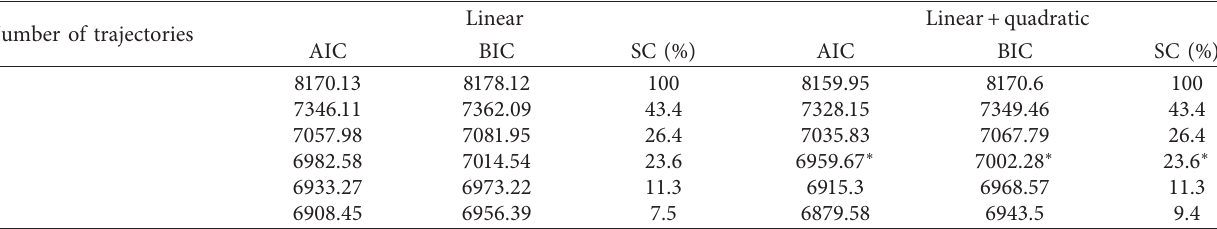
Figure 2: Acute postoperative median pain intensity of patients ( n � 106). Data are presented as median (middle line), interquartile range (box), and range (whiskers). NRS: numerical rating scale. Table 2: Goodness of fit indices for the twelve tested trajectory models.